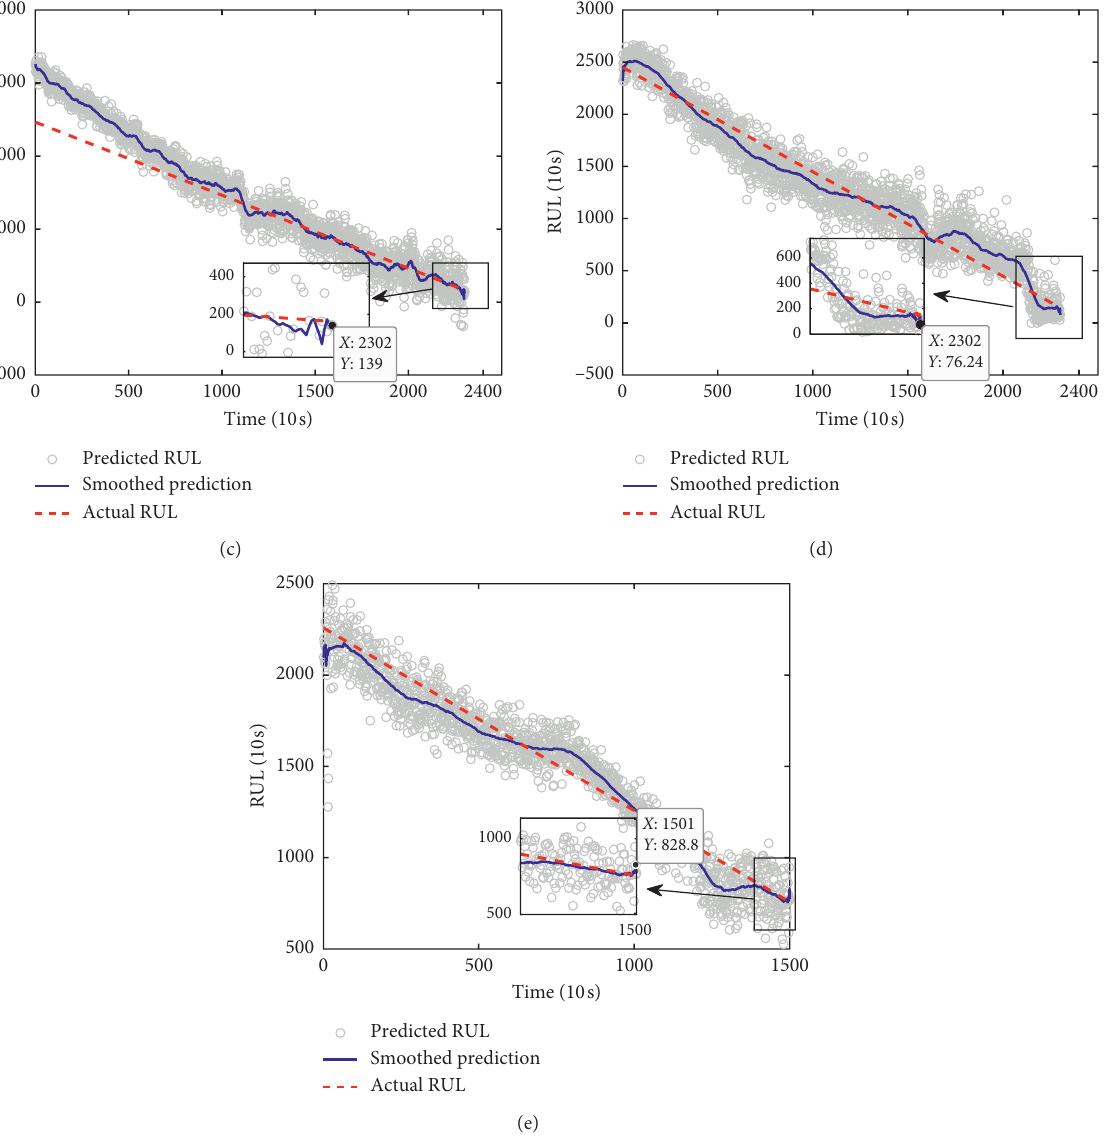
Figure 10: RUL estimation results of the totally 5 testing datasets. (a) Bearing 1–3. (b) Bearing 1–4. (c) Bearing 1–5. (d) Bearing 1–6. (e) Bearing